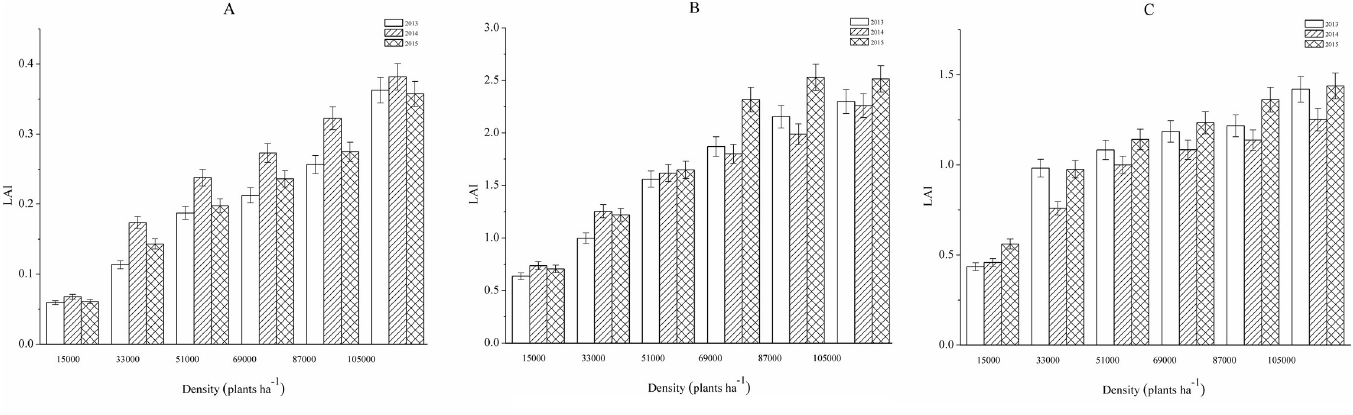
Fig 1. The leaf area indexes at the bud stage (A), flower and boll-forming stage (B) and boll-opening stage (C) under different planting densities from 2013 to